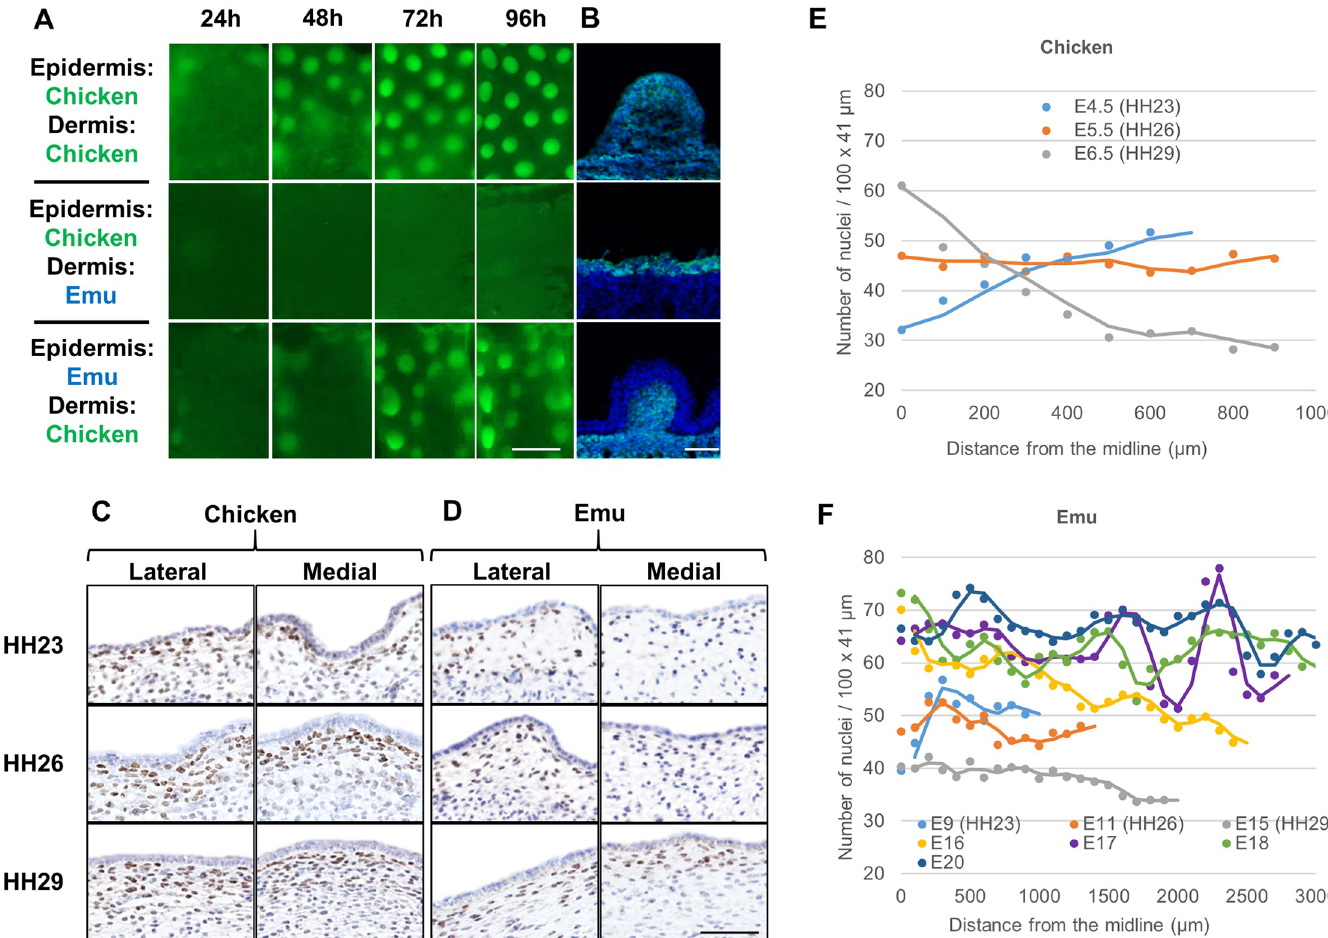
Fig 8. Emu dermis has low density and is not permissive to tract patterning. (A) Epidermal-dermal recombinations between CAG-GFP chicken and emu skin. E6.5 chicken and E14 emu dorsal skins were recombined and cultured for a period of 96 hours. Chicken epidermis and emu dermis do not form feather primordia, whereas emu epidermis recombined with chicken dermis does. Scale bar: 500 μ m. (B) GFP detection of chicken cells in sections of recombined skin, stained with DAPI. Scale bar: 50 μ m. (C) and (D) Immunodetection of TWIST1/2 protein (a nuclear marker of mesenchymal cells, brown) in the lateral and medial regions of the dorsal skin of embryonic stage HH23, HH26, and HH29 (C) chicken and (D) emu embryos. Scale bars: 50 μ m. (E) Quantification of mesenchymal cell densities across the dorsal region of E4.5 (HH23), E5.5 (HH26), and E6.5 (HH29) chicken embryos. (F) Mesenchymal cell density quantification across the dorsal region of emu embryos from E9 to E20. Density increases markedly after E15. The numerical values for E and F can be found in S8 Data. E, embryonic day; GFP, green fluorescent protein; HH, Hamburger Hamilton stage.